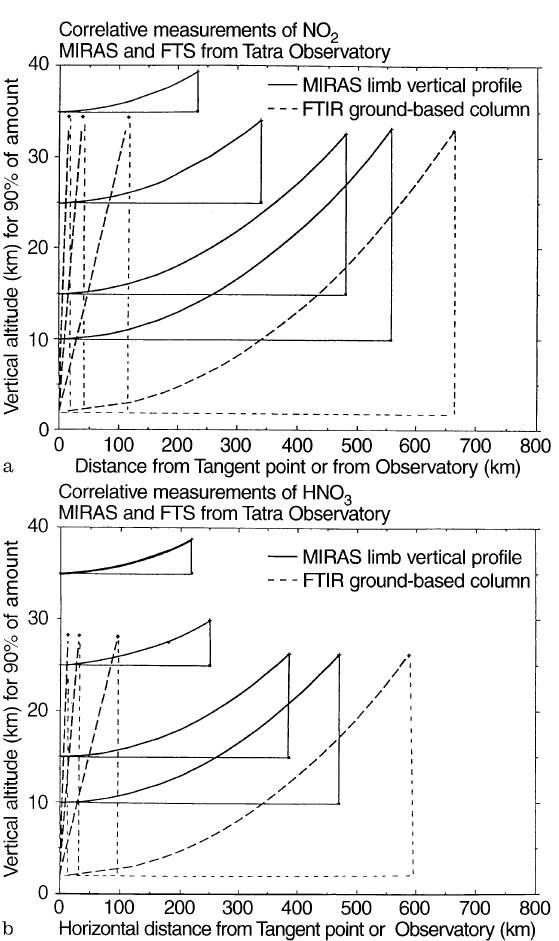
Fig. 5a, b. The comparison of the airmasses sampled in correlative measurements from satellite limb and from ground-based observa- tions for a NO (cid:50) and b HNO (cid:51)